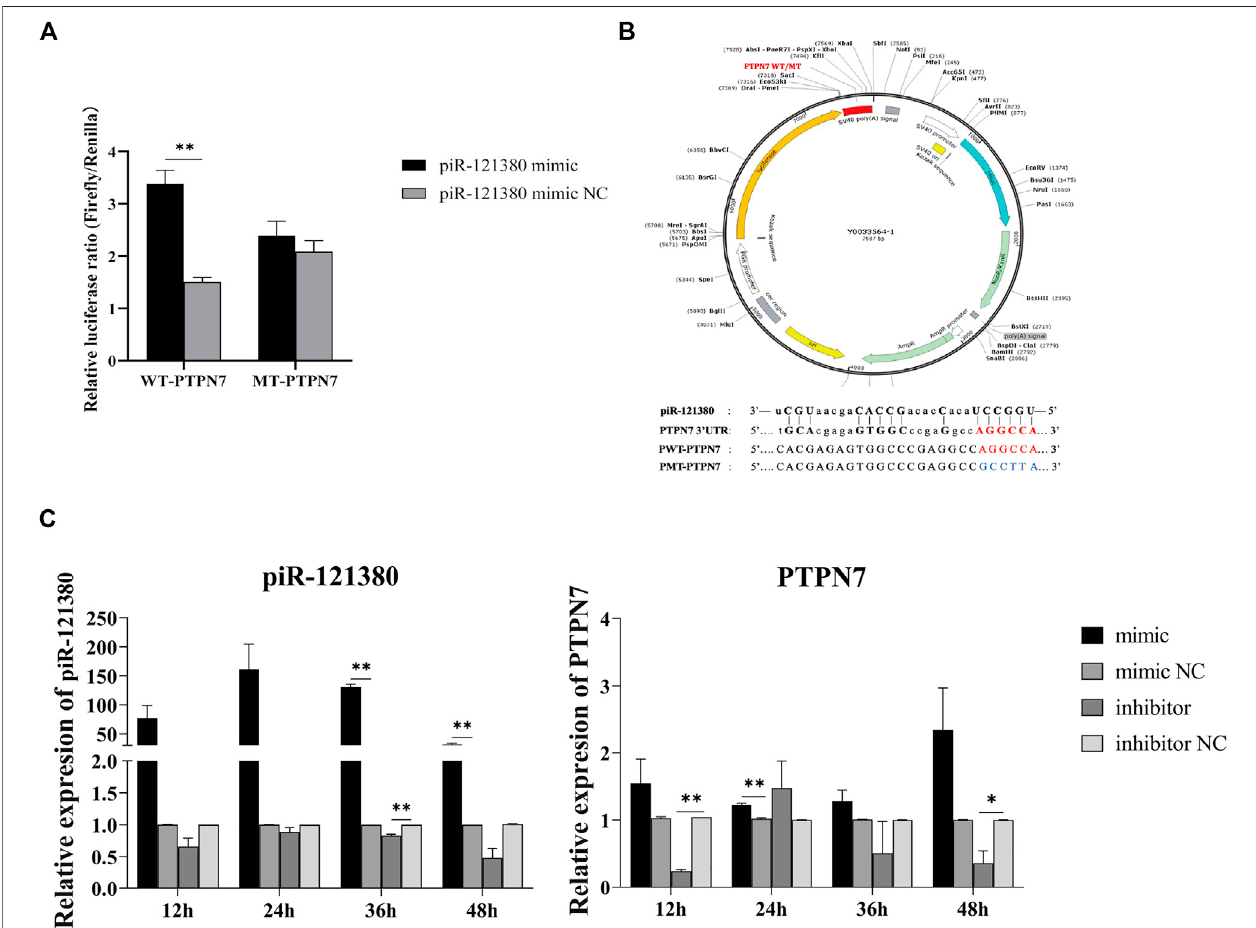
FIGURE 1 | Target gene prediction of piR-121380 and dual-luciferase reporter assay. (A) The result of dual-luciferase reporter assay. ** p < 0.01. (B) The structure ofrecombinantplasmidandthesequencesofwildandmutanttypesandthepredictedtargetsiteofpiR-121380onthe3 ′ UTRofPTPN7inboar.Imperfectbasepairing betweenpiR-121380and3 ′ UTRofPTPN7. (C) TheexpressionofpiR-121380andPTPN7aftertransfectionfrom12to48h,respectively.* p < 0.05.** p < 0.01.Thedata are representative of at least three independent experiments (mean ± SEM).